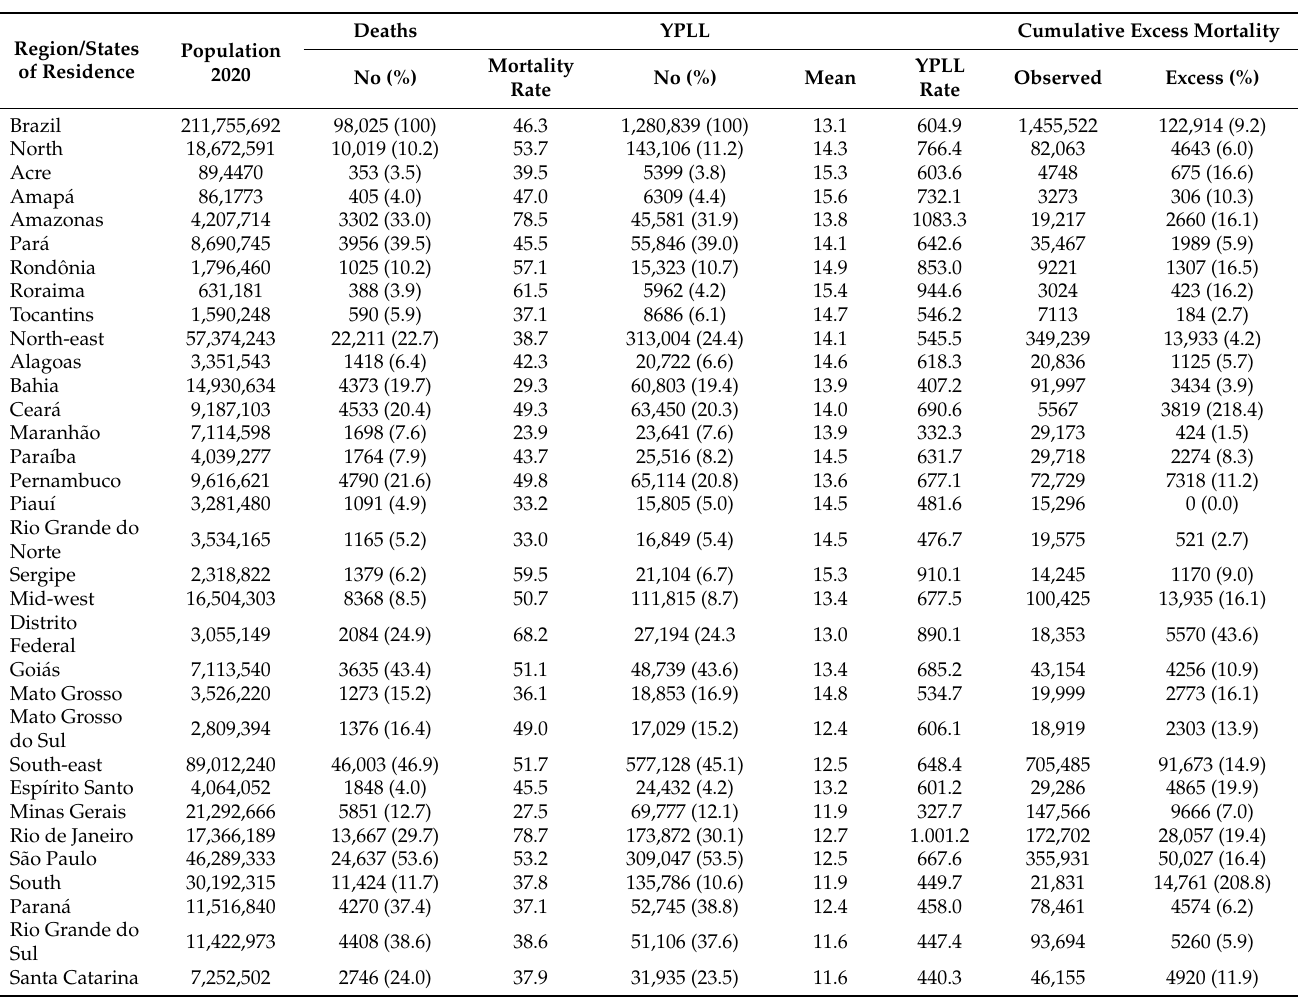
Table A1. Fatalities, years of potential life lost and excess mortality rates in Brazil (2020) due to COVID-19 by region and states of residence.